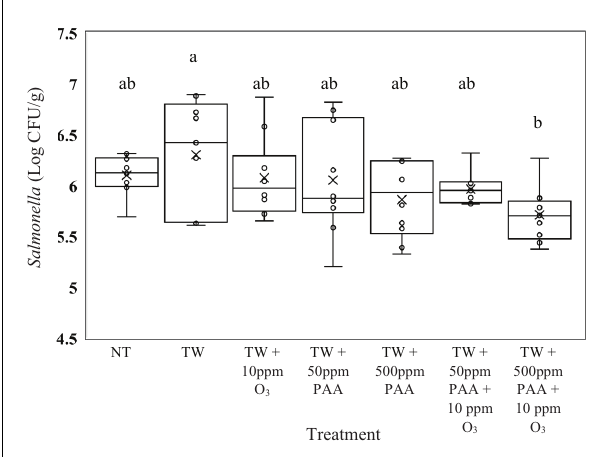
Unlike the recovered Salmonella , E. coli (J53) recovered from the rinsates of carcasses treated with TW did not exhibit significantly higher counts compared to any of the other treated carcasses ( Figure 2 , P = 0.0126).